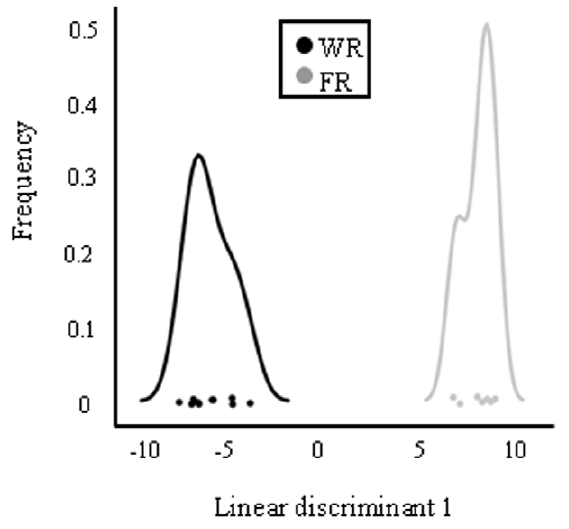
Figure 2. Linear discriminant (LD) analysis of 12 genes significantly different at the mRNA level. Linear discriminant analysis of 12 genes significantly different at the mRNA level clearly separated foundress-reared (FR; putative worker-destined) and worker- reared (WR; putative gyne-destined) larvae. X axis = LD value; Y axis = LD value frequencies. 88% of individuals were correctly classified as FR